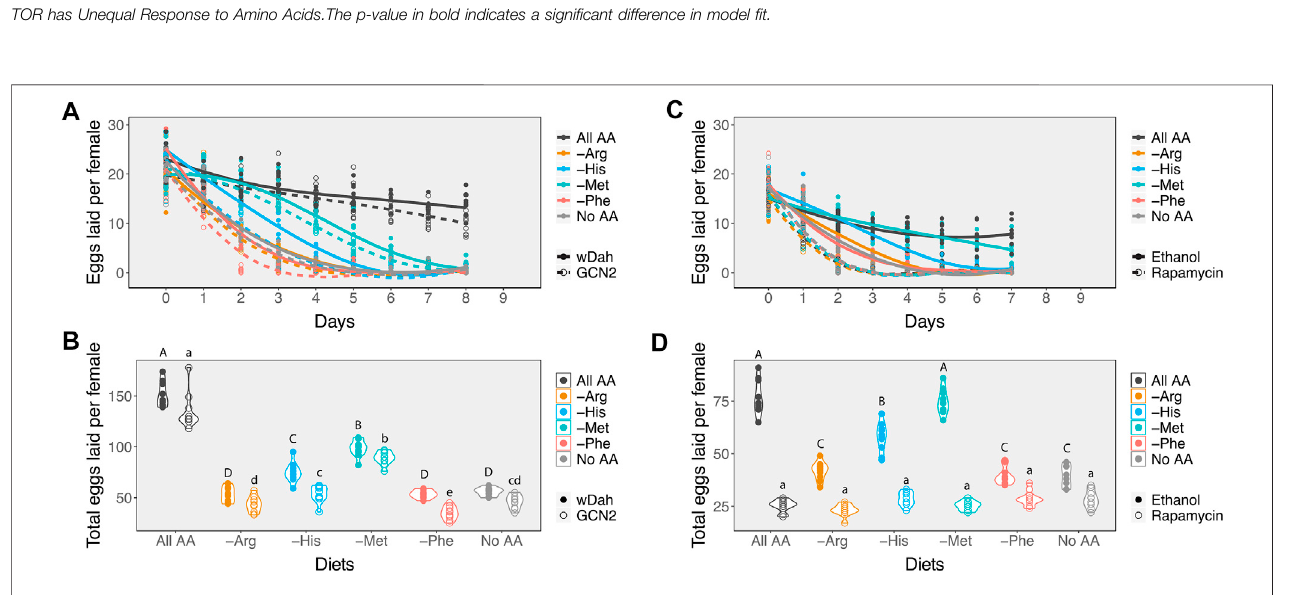
TABLE 2 | Comparison of coef fi cients for egg laying dynamics between White Dahomey and GCN2 Δ fl ies. Diets were compared using self-starting logistics models.